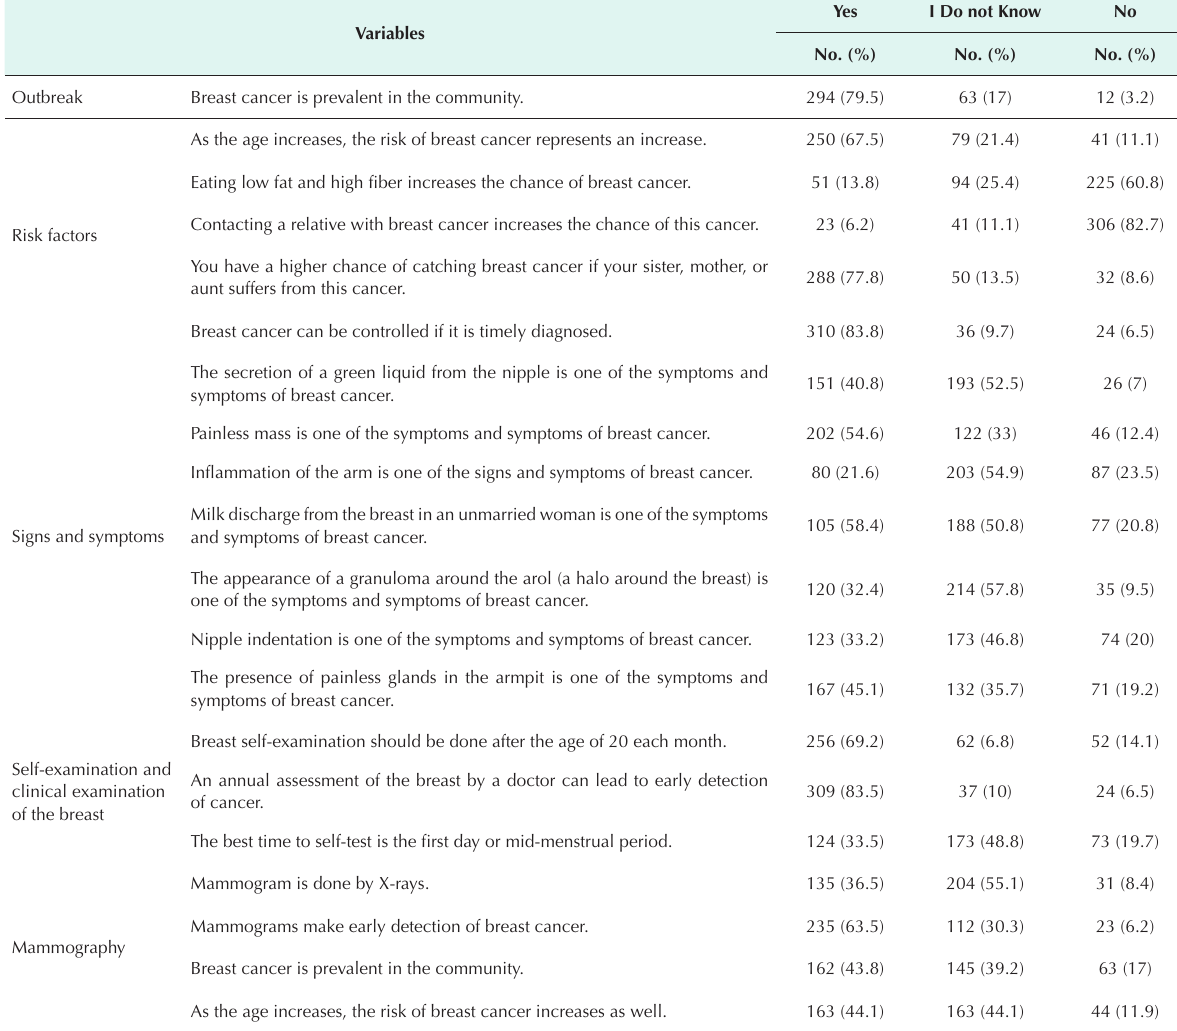
Table 2. Frequency and Percentage of Responding to Questions by Surveyed Subjects Regarding Knowledge of Breast Cancer Variables